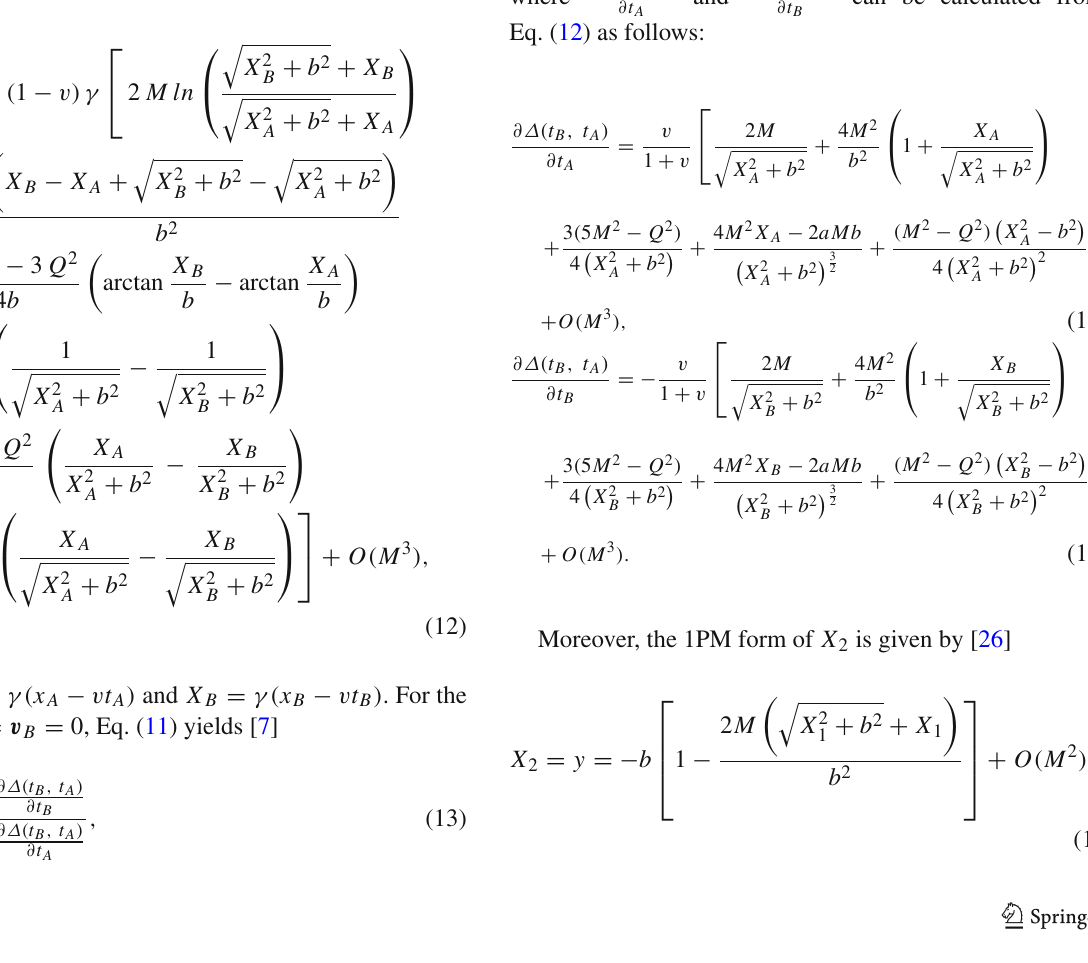
Fig. 1 Schematic diagram for the equatorial propagation of light in the gravitational field of the moving KN black hole. We assume that light takes the prograde motion relative to the lens’s spin. The gravitational